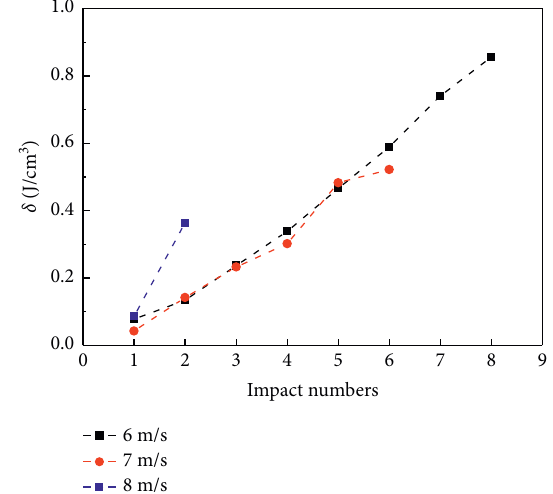
Figure 12: Relationships between δ and impact numbers under diferent impact